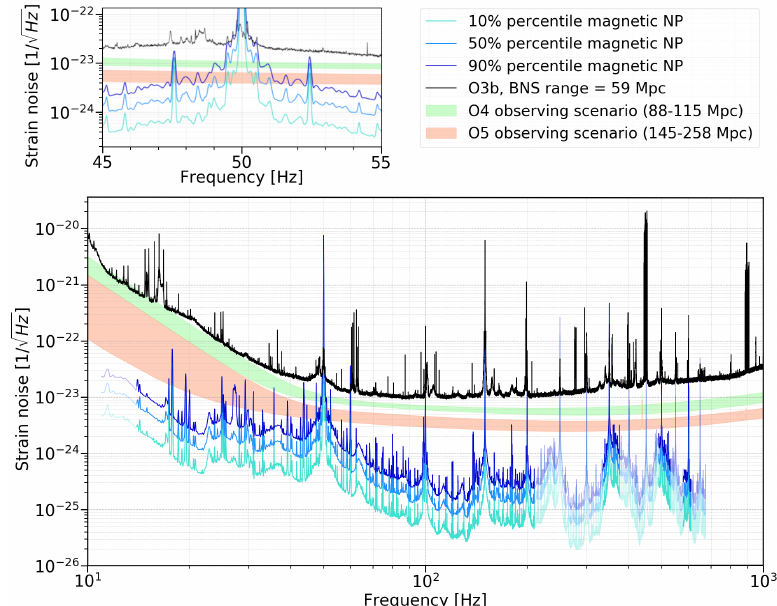
Figure 8. Noise projection (NP) of ambient magnetic fields in the central building. The strength of the ambient magnetic field is visualized in the form of percentiles computed over one week period with a frequency resolution of 0.05 Hz. For each frequency at which we determined the coupling function we took the maximum measured value among all injections in the CEB during O3. To produce a continuous noise projection we applied a linear interpolation between frequencies at which magnetic injections were performed. In regions with a partially transparent color, the coupling function only gives an upper-limit. The projected noise (blue shaded curves) is compared with the O3b measured sensitivity (black curve) and with Virgo future observing scenarios, named O4 and O5.